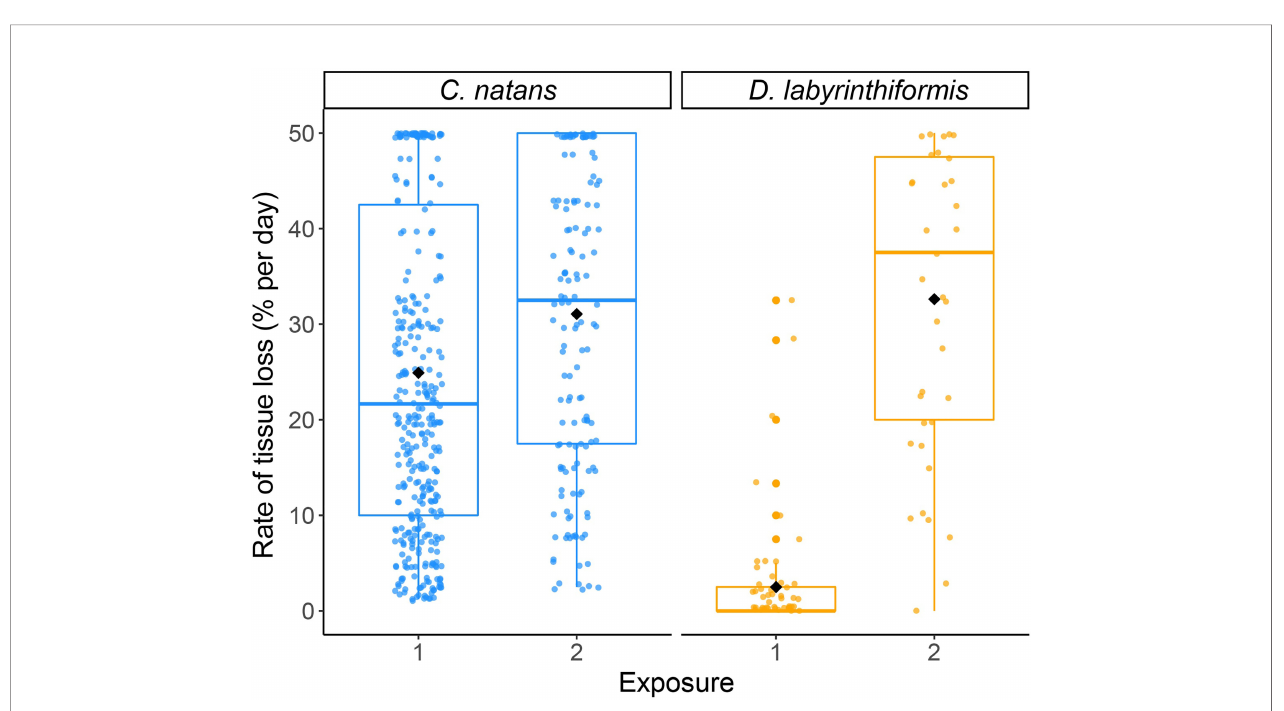
FIGURE 6 | Proportional lesion progression rates (log-transformed) as a result of SCTLD exposure in brain coral recruits. Points show measurements of tissue loss (% of initial area per day) for individual recruits, which were jittered to reduce overlap. Black diamonds show mean rates for each species during each